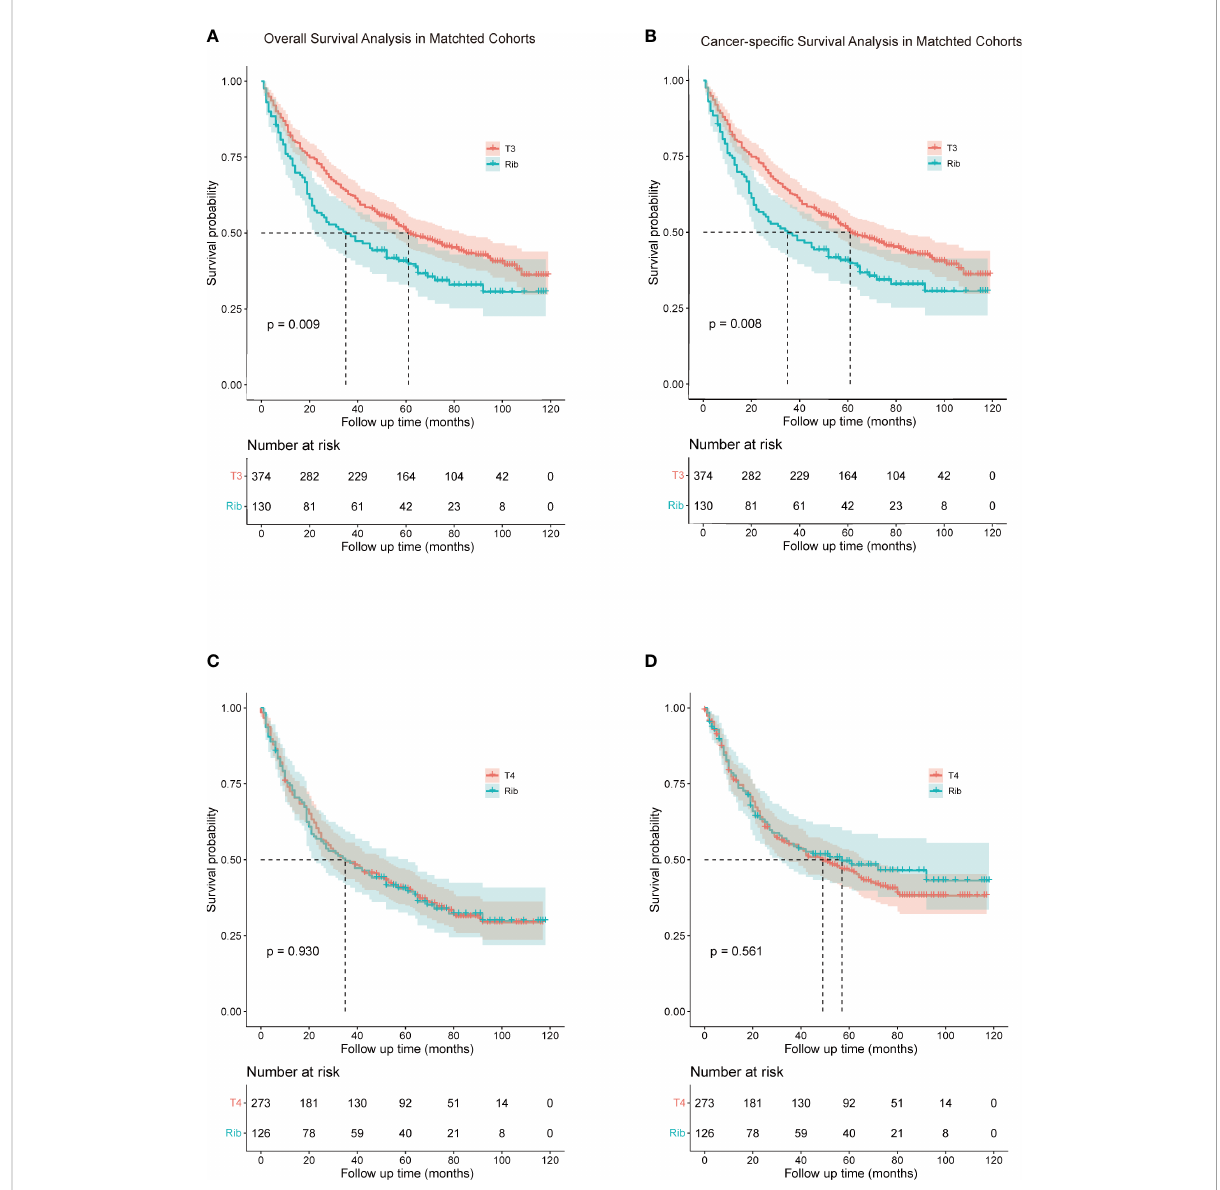
FIGURE 4 Comparison of overall survival (A, C) and cancer-speci fi c survival (B, D) rib invasion and its matched cohort from the other pT3 and pT4 groups. (A, B), comparison between rib invasion and matched to the other pT3 group; (C, D), comparison between rib invasion and the matched pT4 group. Other pT3 referred to the pT3 patients without rib